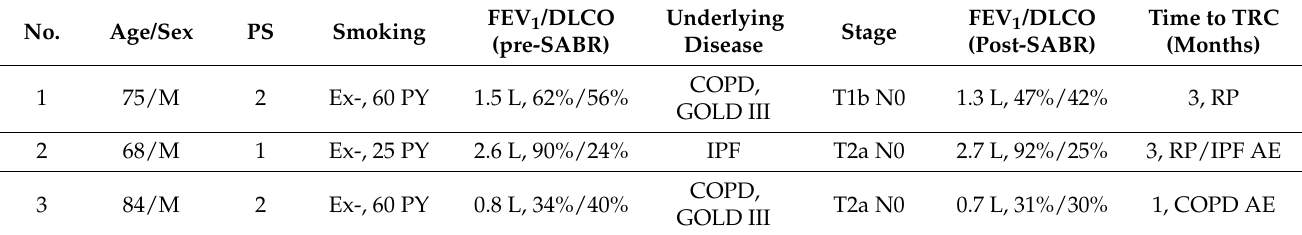
Table 3. Clinical courses of patients requiring hospitalization after